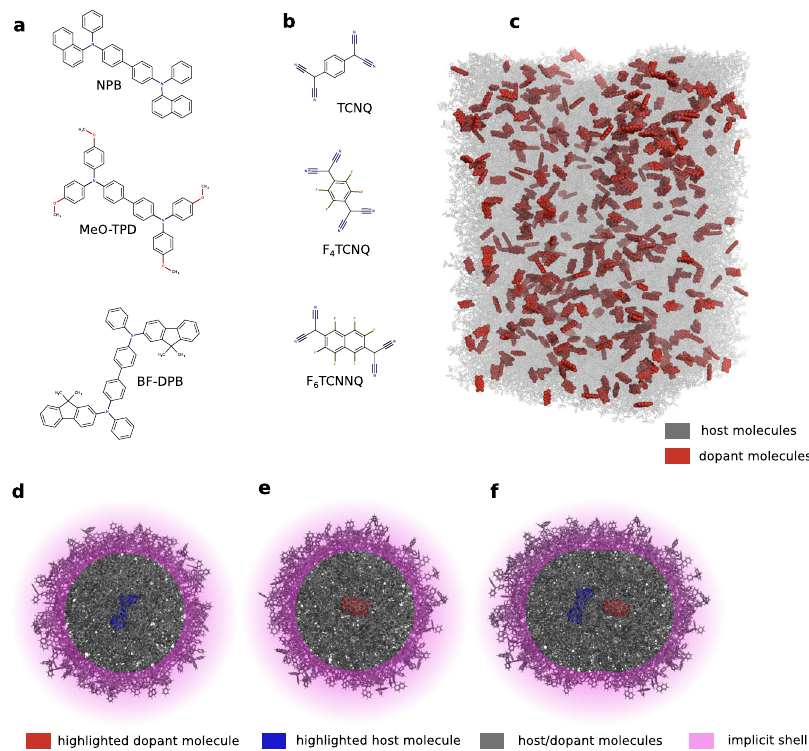
Fig. 1 | Doped organic semiconductor materials and morphologies. a Host molecules. b Dopants TCNQ, F 4 TCNQ, and F 6 TCNNQ (top to bottom) with pro- gressivelyincreasingquadrupolemomentscomponent Q zz (31.6 ea 2 0 ,36.8 ea 2 0 ,51.0 ea 2 0 , respectively). c Distribution of dopants in a host matrix, exempli NPB:F